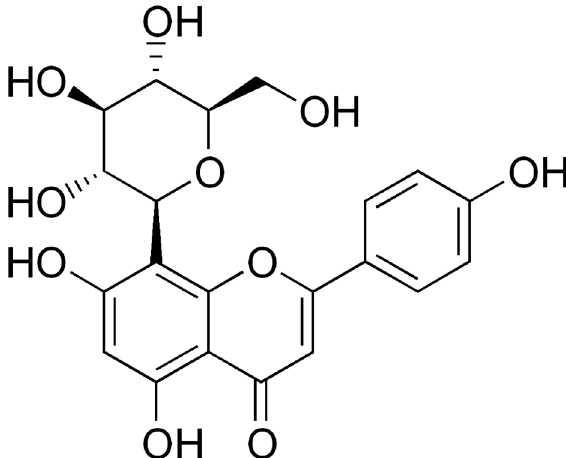
Figure 2. Chemical structure the vitexin of Croton antisyphiliticus